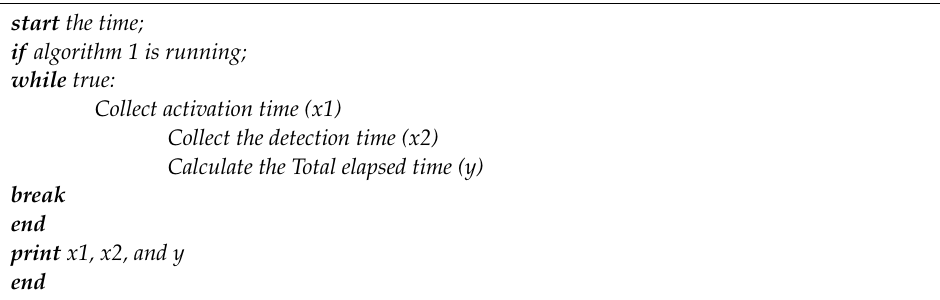
Algorithm 2 : Algorithm that is used for data collection for the sampling and resampling algorithm to study latency in a